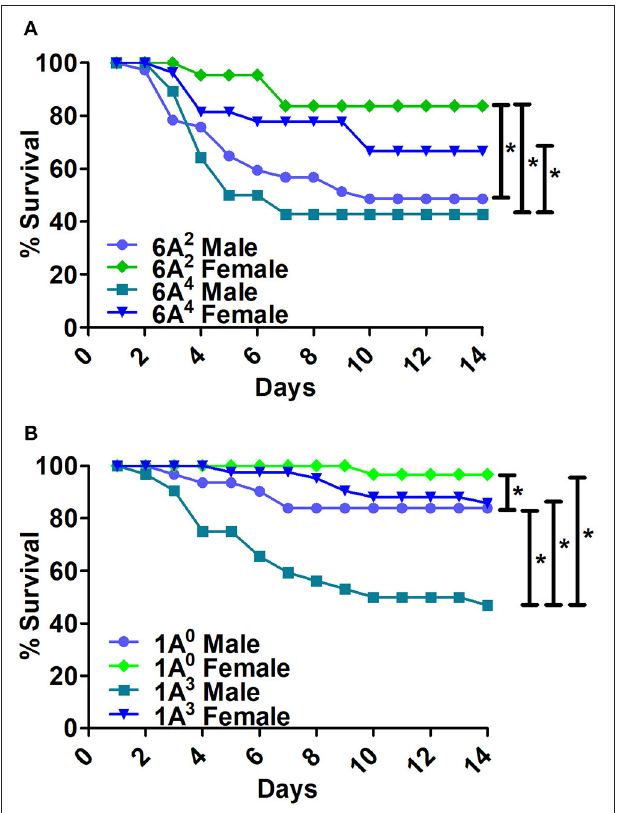
FIGURE 4 | Comparison of survival among SP-A1 and SP-A2 variants after K. pneumoniae infection. (A) Depicts differences in survival among males and (B) Depicts differences among females of SP-A1 (6A 2 , 6A 4 ) and SP-A2 (1A 0 , 1A 3 ). Mouse survival was monitored for 14 days after infection. Significant differences for survival are indicated * p < 0.05. The number of mice used for each group is shown in Figure 2